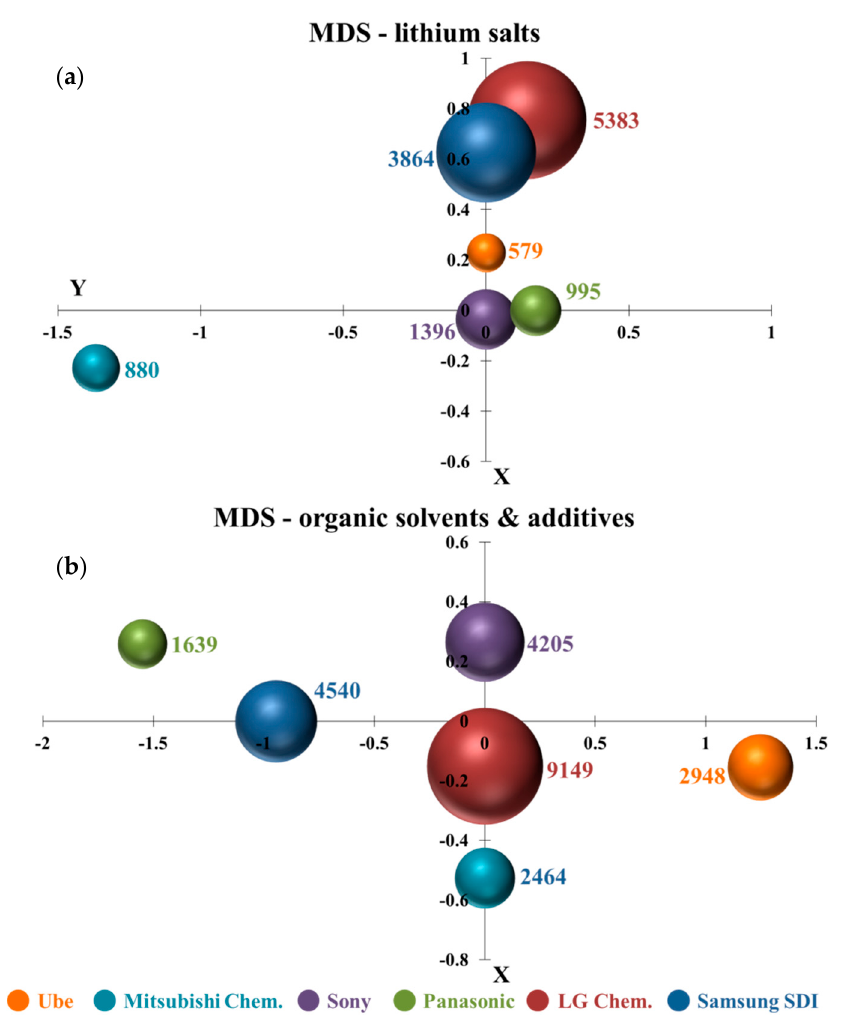
Figure 5. Multi-dimensional scaling analysis (MDS): ( a ) H01M10 / 0568 (lithium salts) and ( b ) H01M10 / 0567 and 0569 (organic solvents and additives).